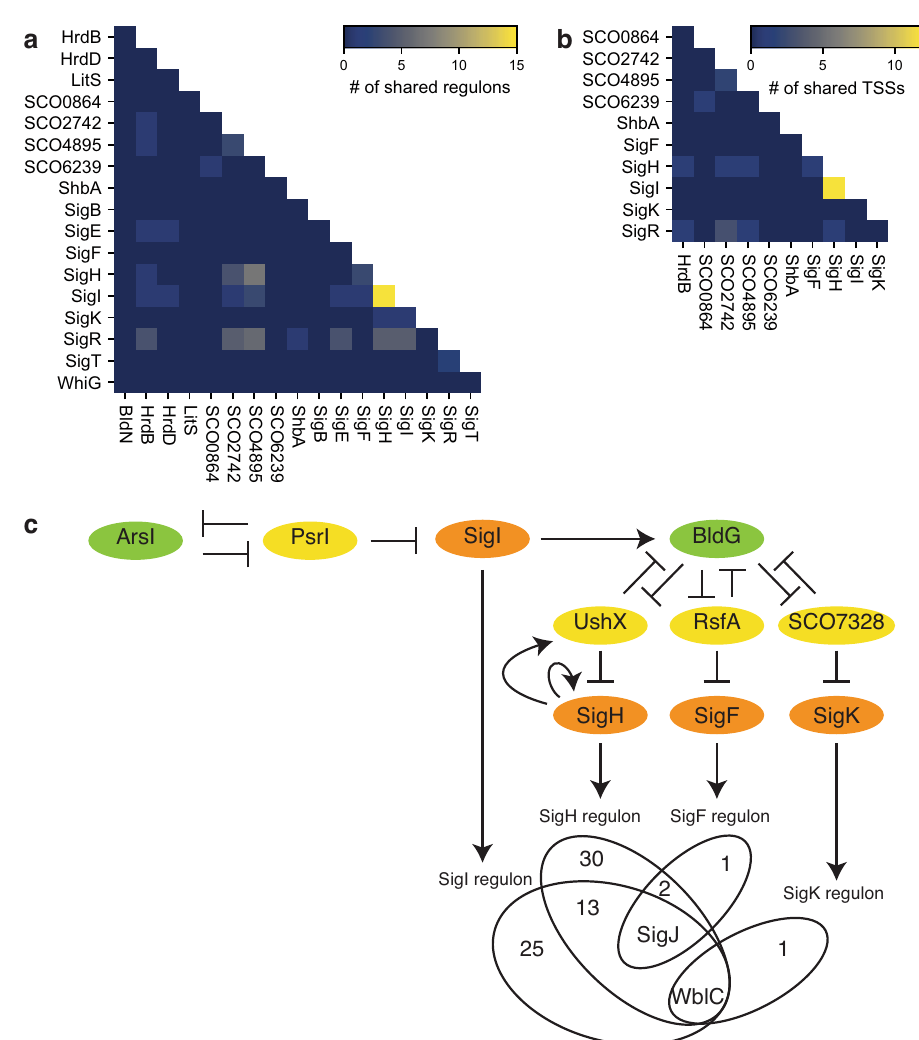
Fig. 5 Crosstalk of sigma factors. a Heatmap of the number of shared regulons between each pair of sigma factors. These regulons include the previously identi fi ed target genes. b Heatmap of the number of shared TSSs between each pair of sigma factors. Only TSSs identi fi ed by RIViT-seq were used. c Regulatory network controlled by SigH, SigI, SigF and SigK. Green, yellow and orange ovals indicate anti-anti-sigma factors, anti-sigma factors and sigma factors,